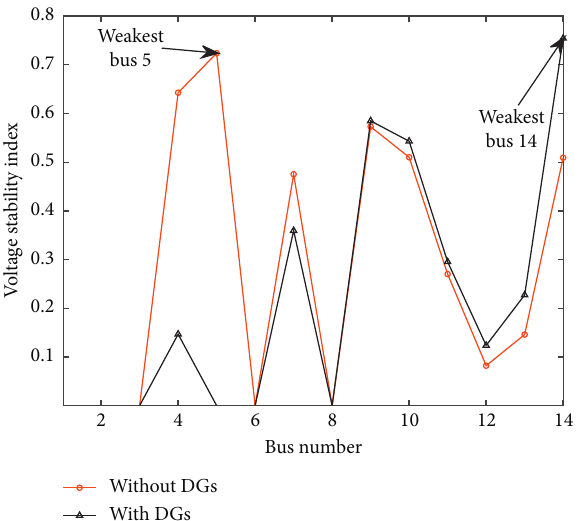
Figure 7: The voltage stability index of the 14-bus system when using MCPF without and with DG at bus